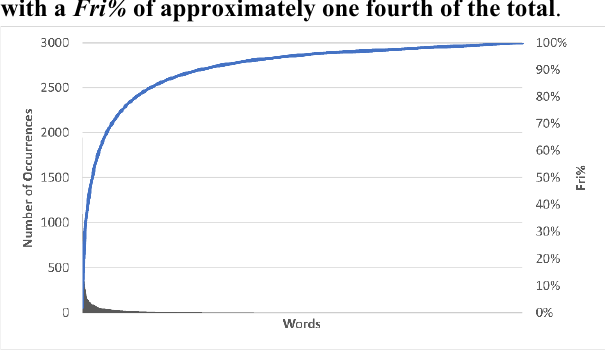
Figure 1. Histogram of the N1 (12.448) words from